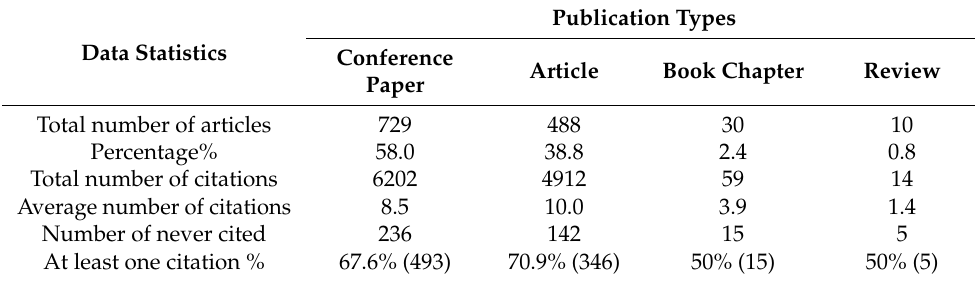
Table 6. Statistics based on the number of citations of different document types.